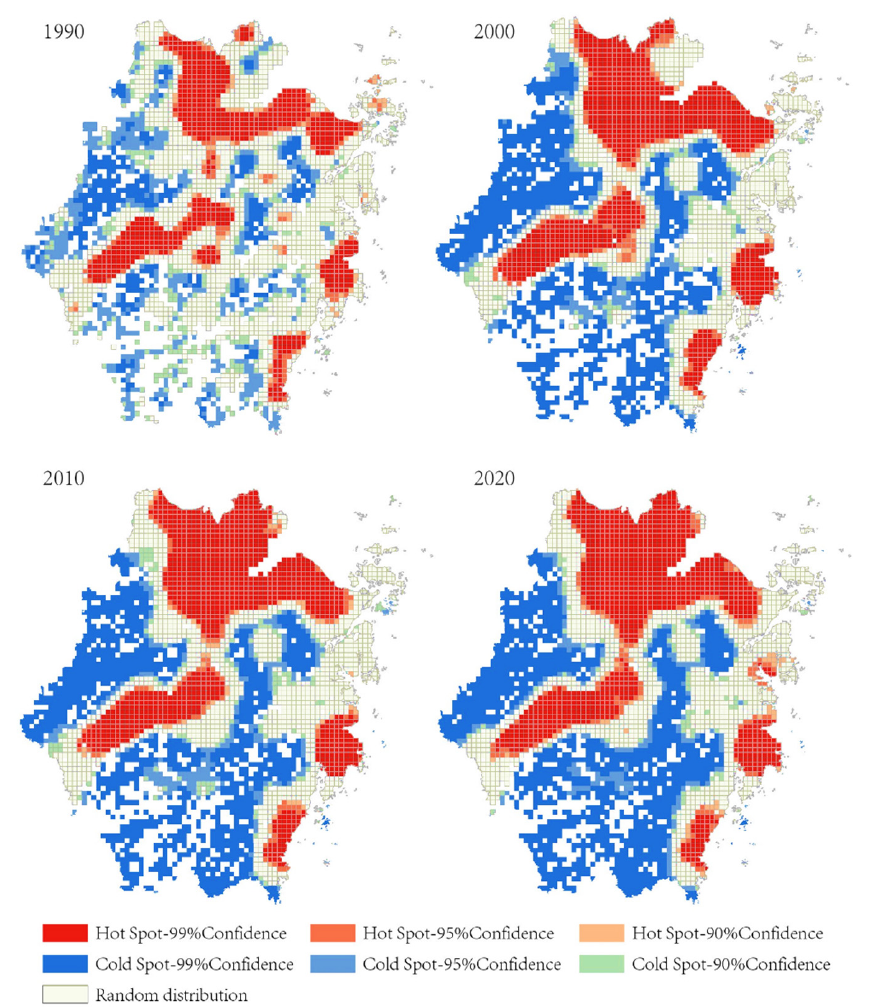
Figure 7. Evolution of urban development hotspots in Zhejiang Province from 1990 to 2020 (5 km × 5 km